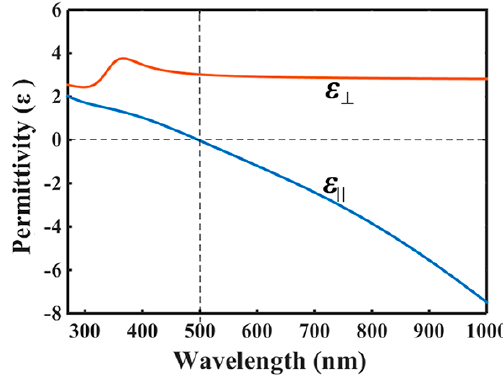
Figure 2. Real parts of the ε ⊥ and ε || of dielectric permittivity of the HRA calculated by using the EMT.